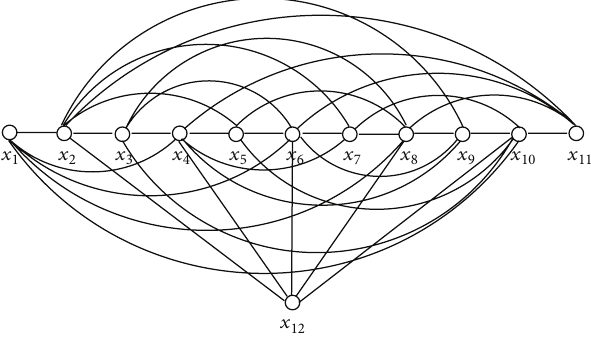
Figure 6: A (problematic) graph with even number of